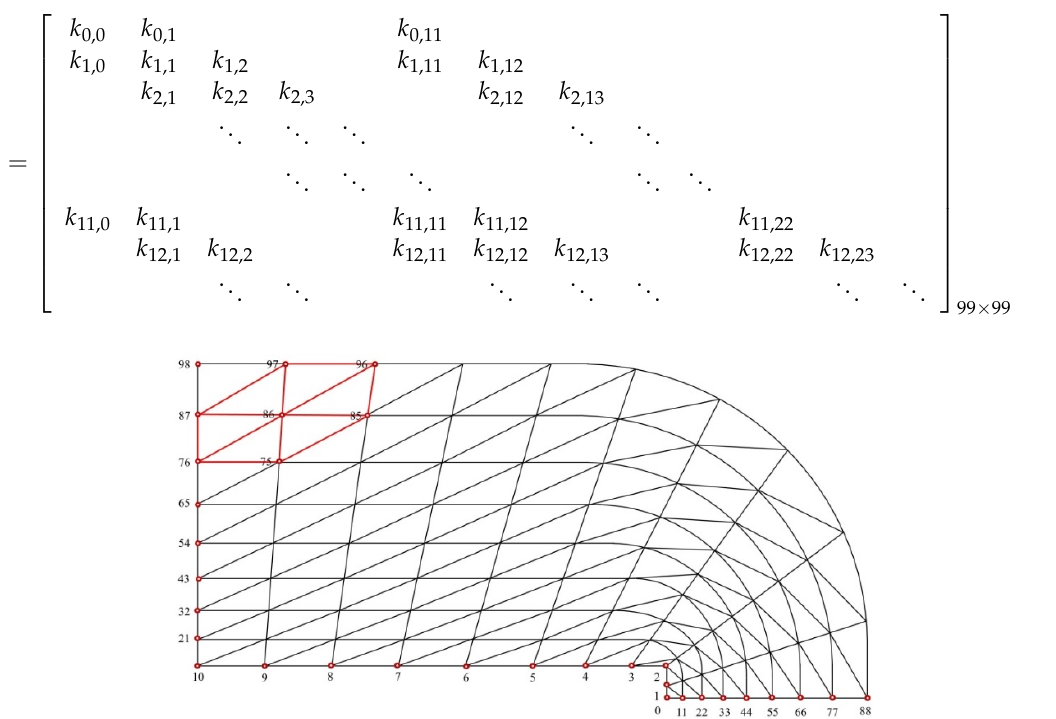
Figure 2. Mesh generation of the model of heat emitting from a surrounding rock at the drifting face.